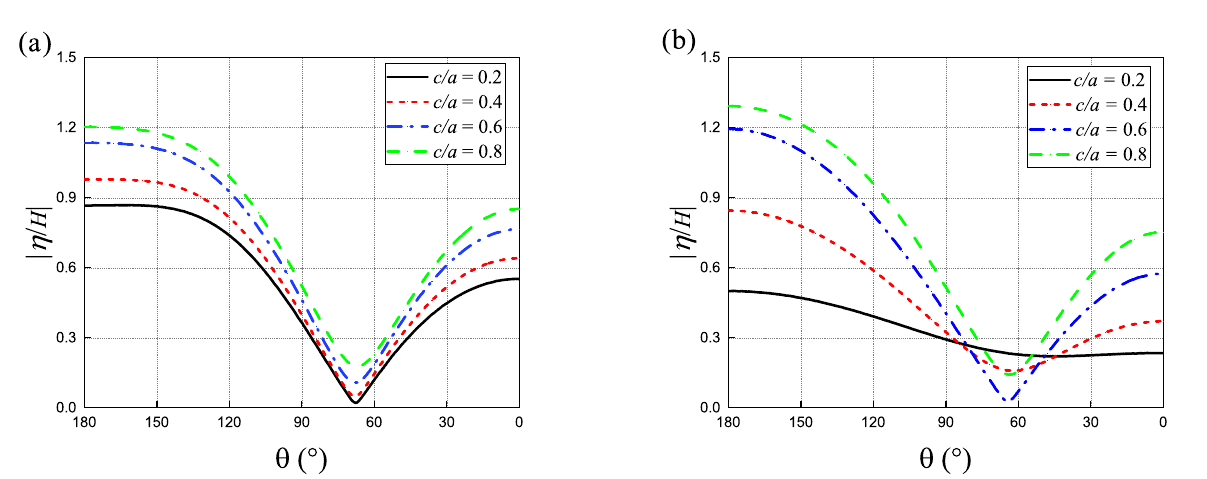
Figure 10. Wave run-ups on the outer cylinder and the inner cylinders versus θ for different b / a with C w = 0.8, e / a = 1, G 1 = 1, β = 0, and h / a = 1.5: ( a ) the outer cylinder, ( b ) the inner cylinder.